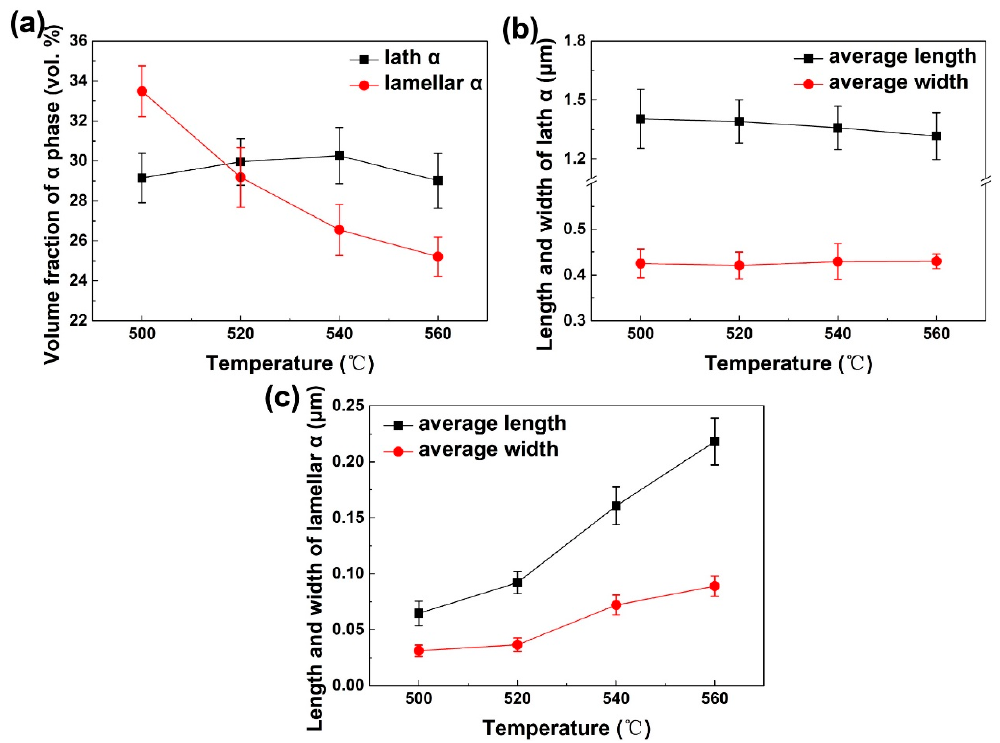
Figure 8. The variations of ( a ) volume fraction of lath and lamellar α phases, ( b ) average length and width of lath α , and ( c ) average length and width of lamellar α with temperatures. Materials 2019 , 12 , x FOR PEER REVIEW Table 3. Microstructure features of α phases after aging for 8 h.